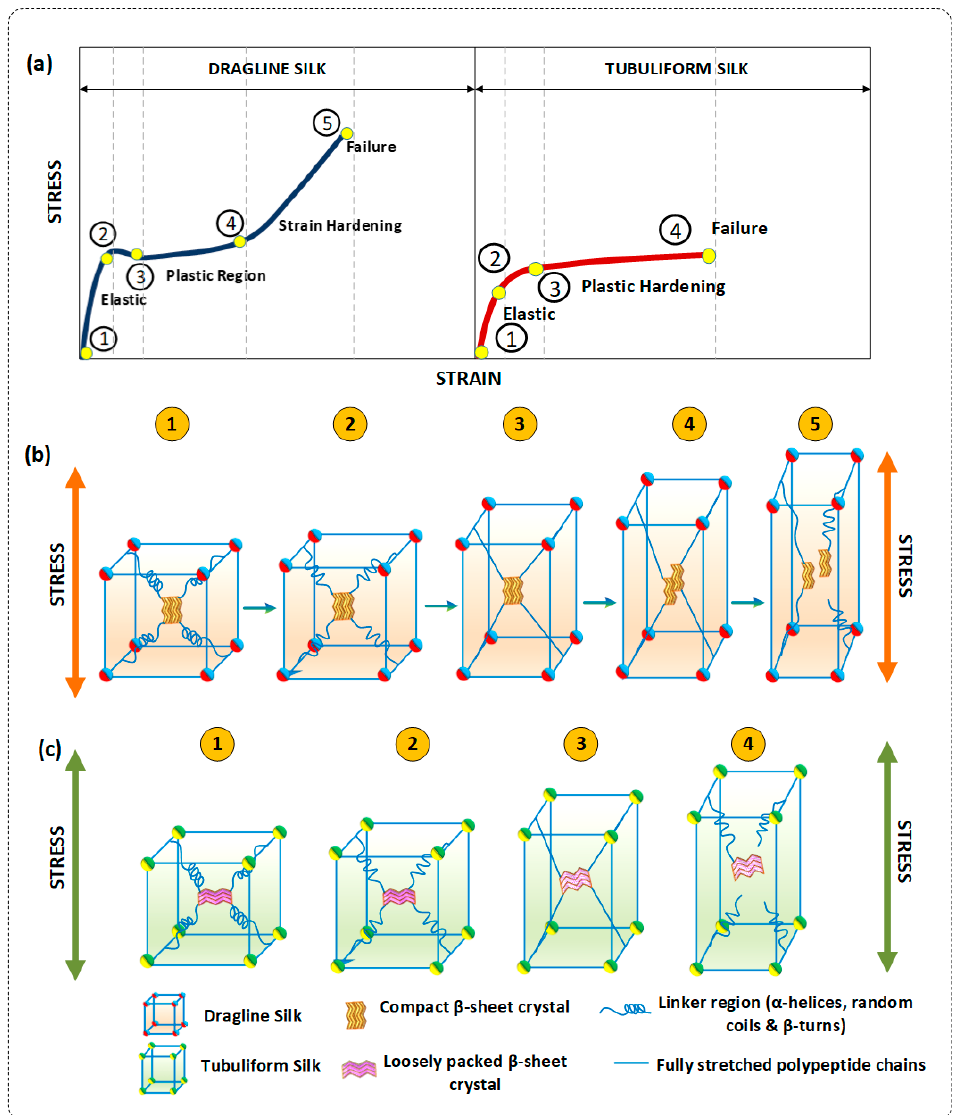
Figure 8. ( a ) Schematic for different stages of deformation in dragline silk and tubuliform silk (Reproduced with permission from [7], 2006 Sage Publications); ( b ) deformation model of dragline silks; and ( c ) deformation model of tubuliform silks.